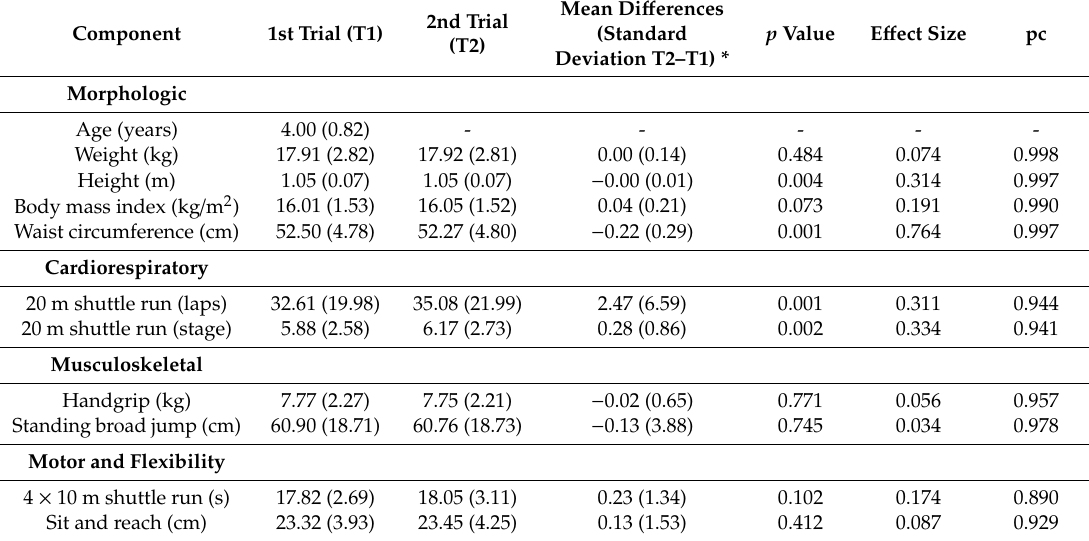
Table 1. Test (T1), retest (T2), mean di ff erences (T2–T1), and concordance correlation coe ffi cient (pc) of “Fuprecol Kids”